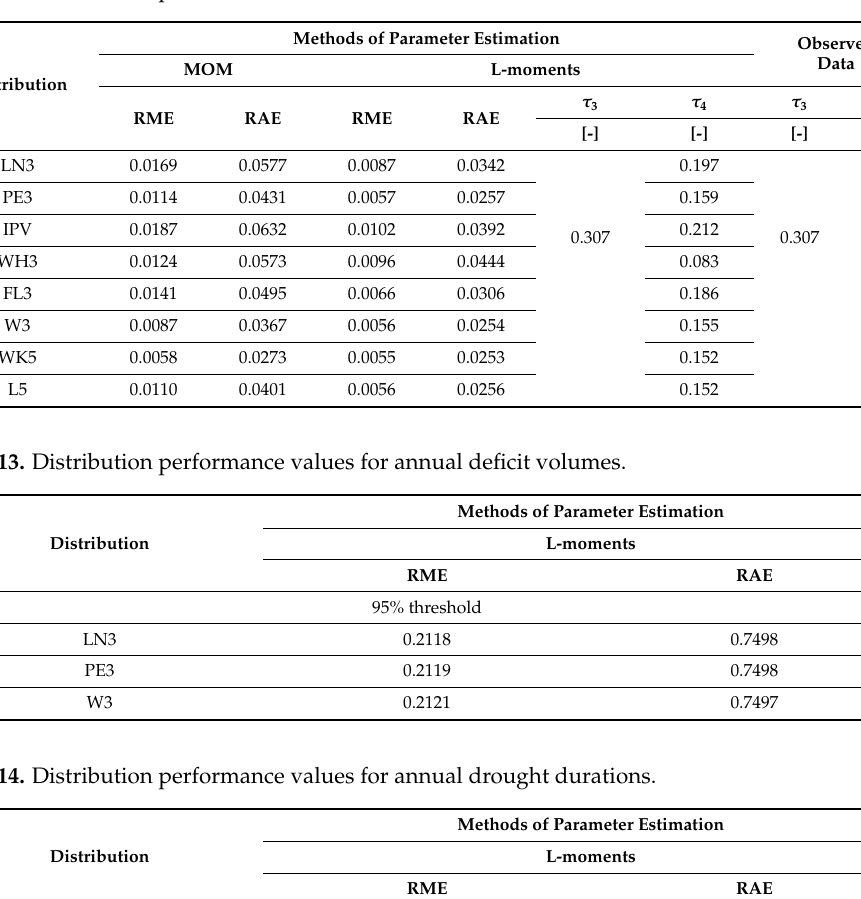
Table 12. Distribution performance values for minimum annual flows.